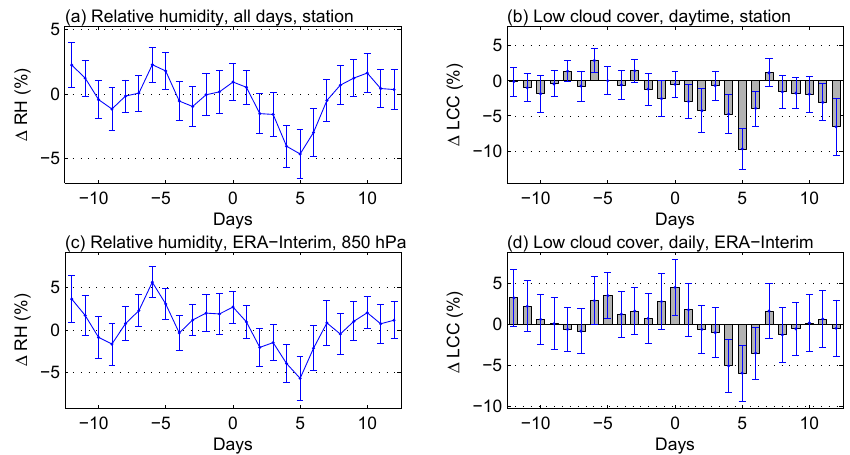
Figure 4. Station observational relative humidity anomalies ( (cid:49) RH) estimated from all available days (a) and the daytime low cloud cover (LCC) anomalies (b) during the holiday from 1979 to 2012. ERA-Interim (cid:49) RH at 850hPa (c) and the daily LCC anomalies (d) during the holiday. Standard error is shown as error bars.